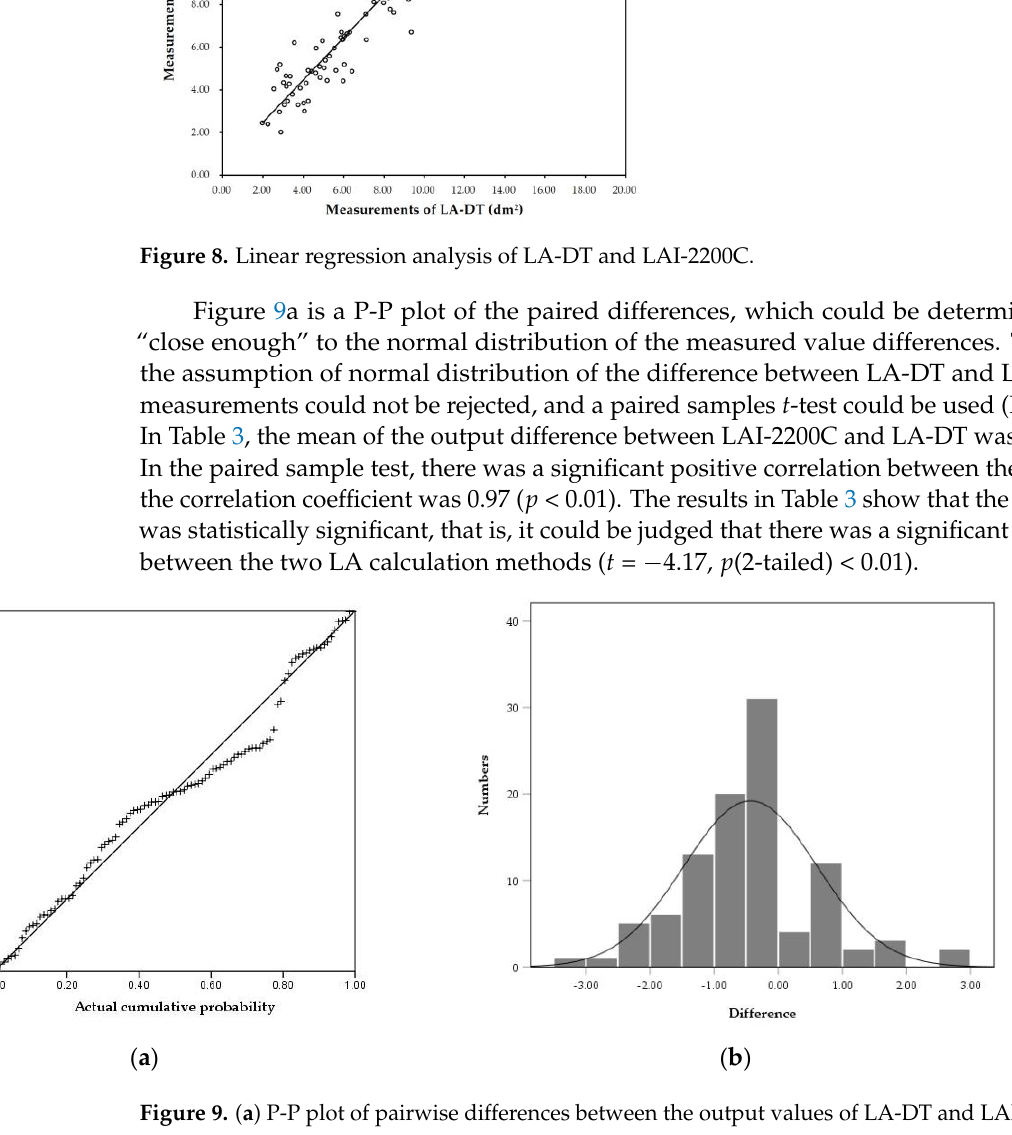
Figure 9. ( a ) P-P plot of pairwise differences between the output values of LA-DT and LAI-2200C; ( b ) Normal distribution of pairwise differences.